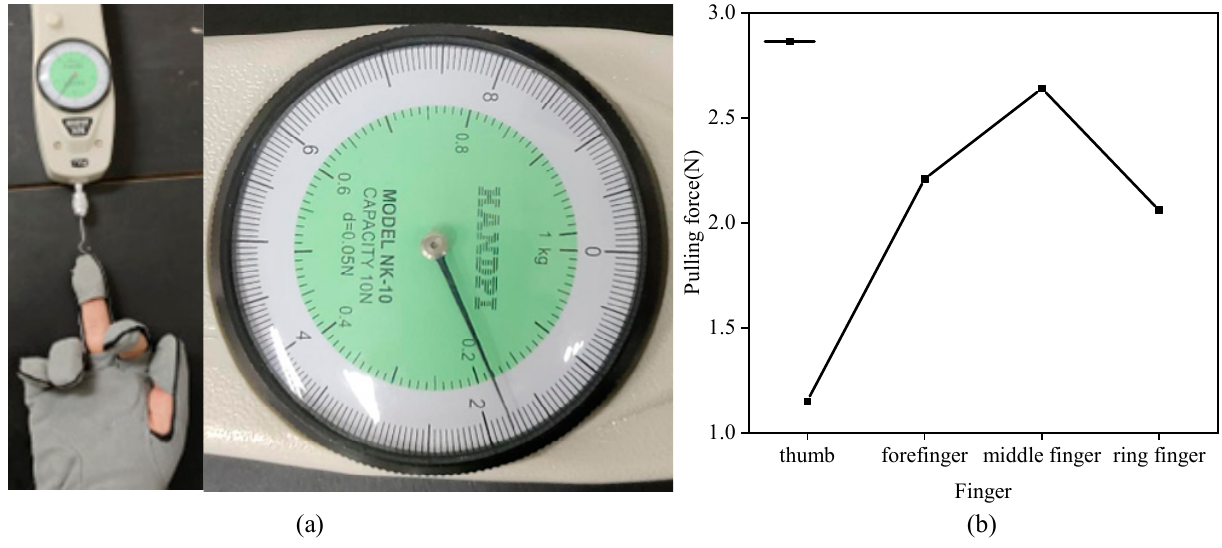
Figure 13. Finger pull test in rehabilitation training mode. ( a ) Finger tension measurement experi- ment; ( b ) Average diagram of tension on each fi nger.